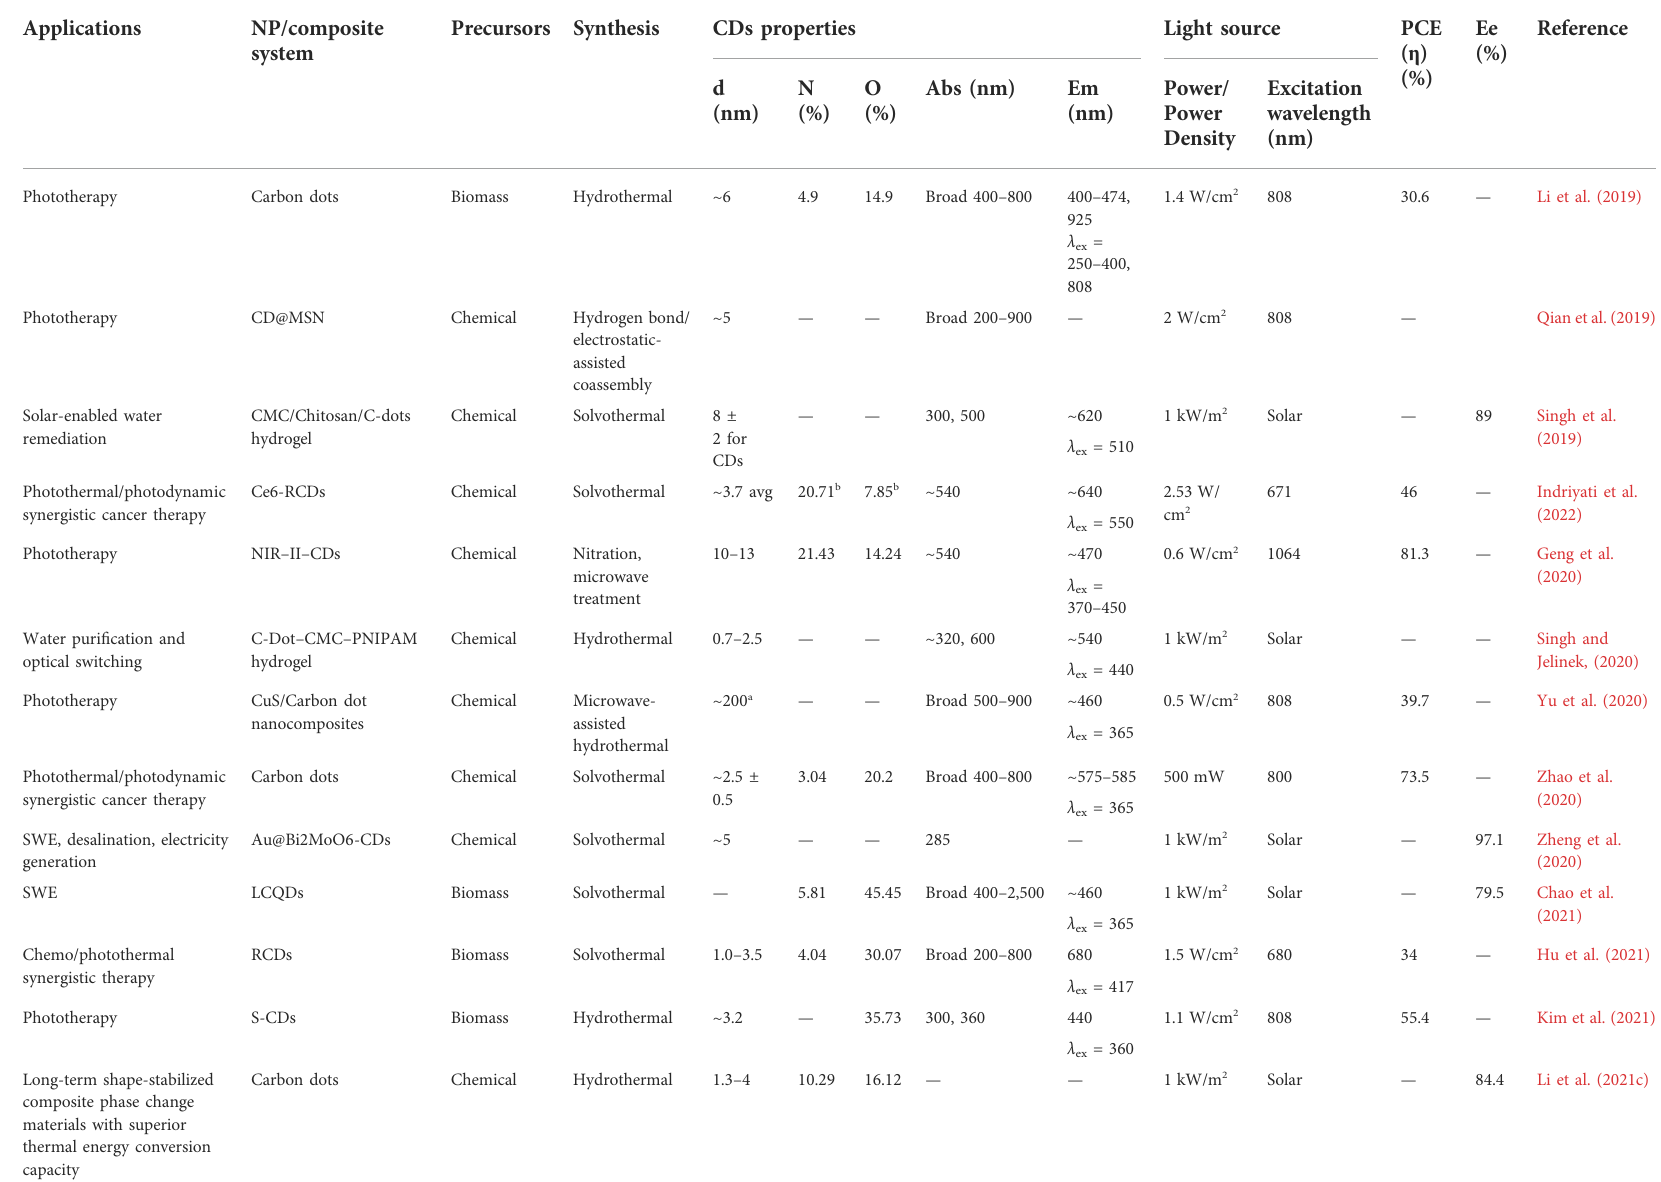
TABLE 1 ( Continued ) Photothermal application, synthesis protocol, properties, and PCE of carbon